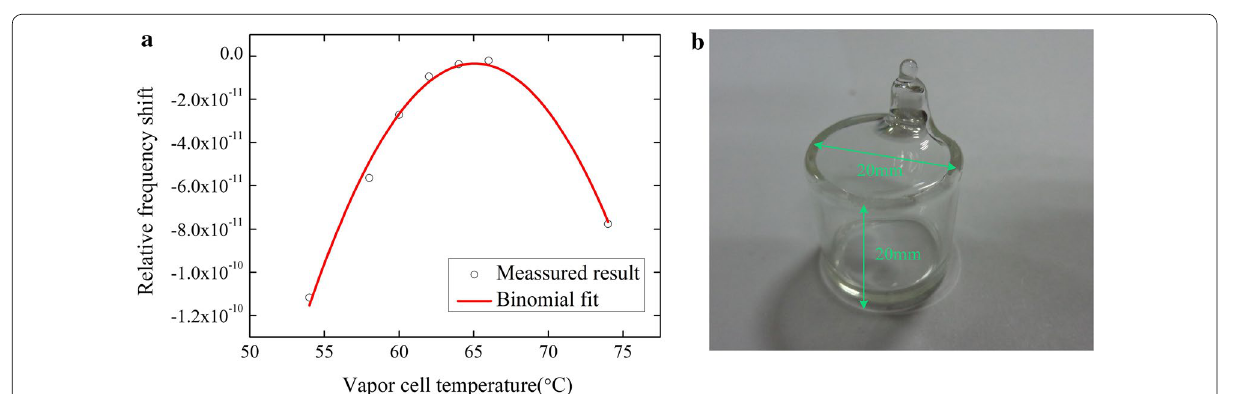
Fig. 3 Relative frequency shift with temperature ( a ) and photo ( b ) of the gas